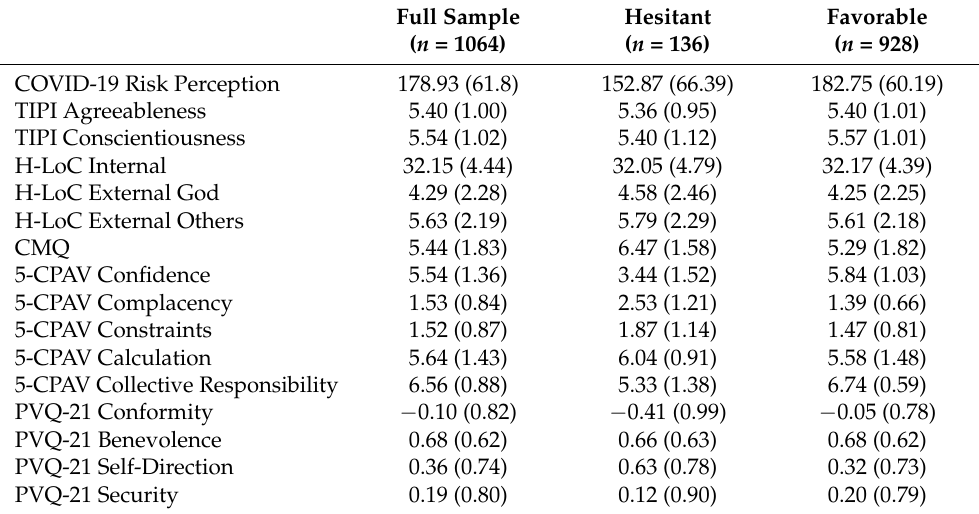
Table 1. Means and standard deviations for all psychological variables examined in this study, separately for the entire sample ( n = 1064) and for the two vaccine-related behavior groups (favorable, n = 928; hesitant, n = 136).